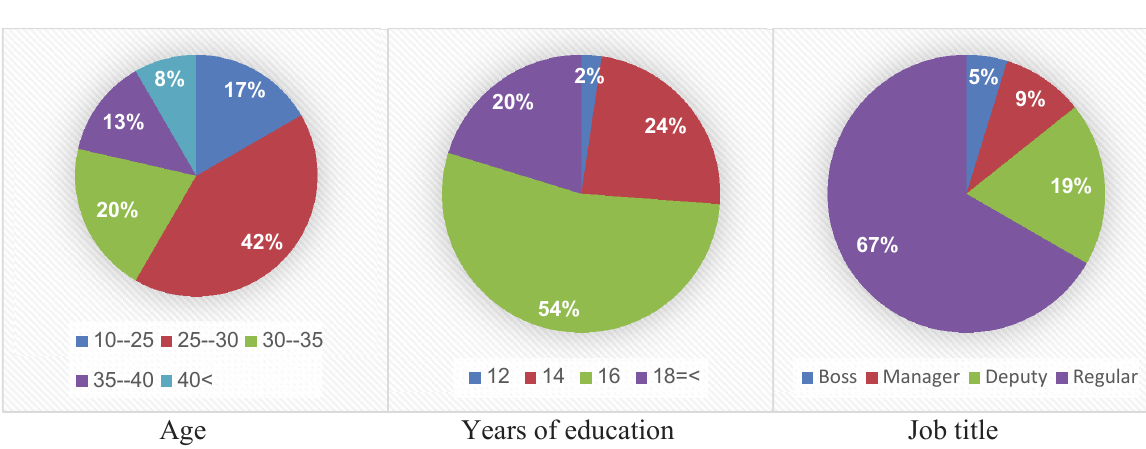
Fig. 2. Personal characteristics of the participants